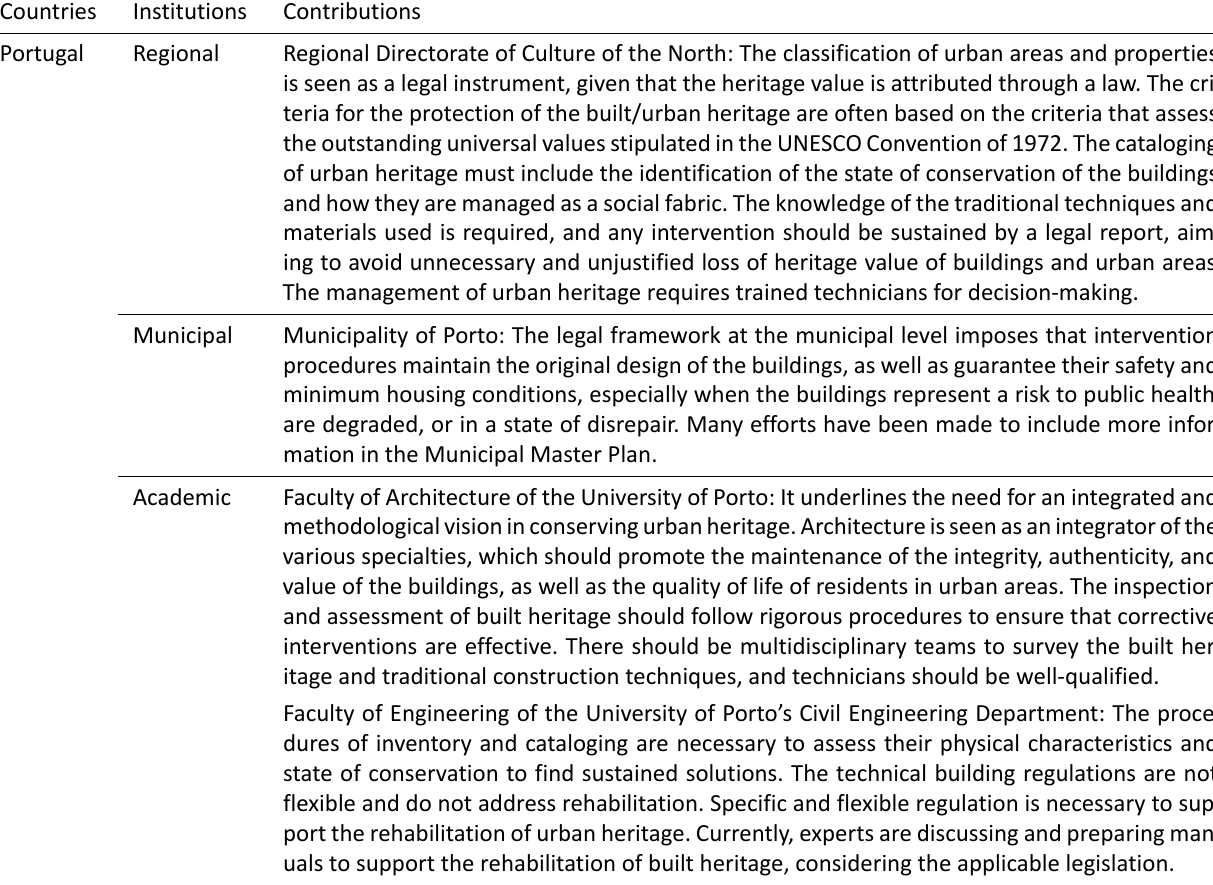
Table 3. (Cont.) Institutional stakeholders’ contributions to building regulations concerning urban